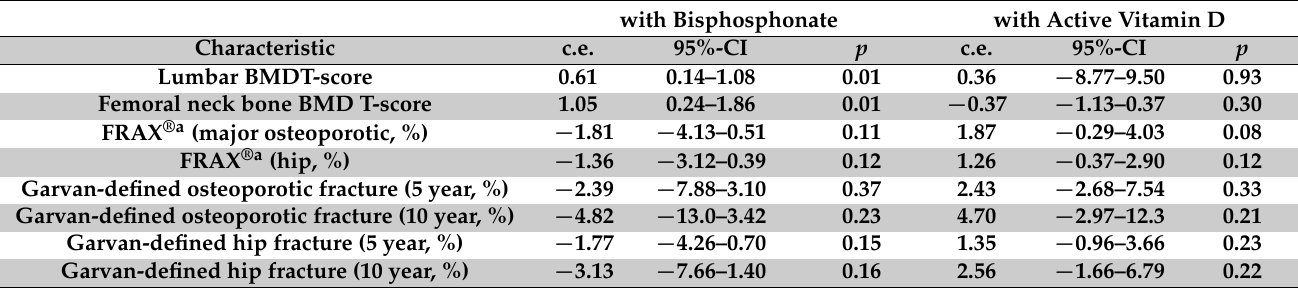
Table 3. Association between the prevention of glucocorticoid-induced osteoporosis and score